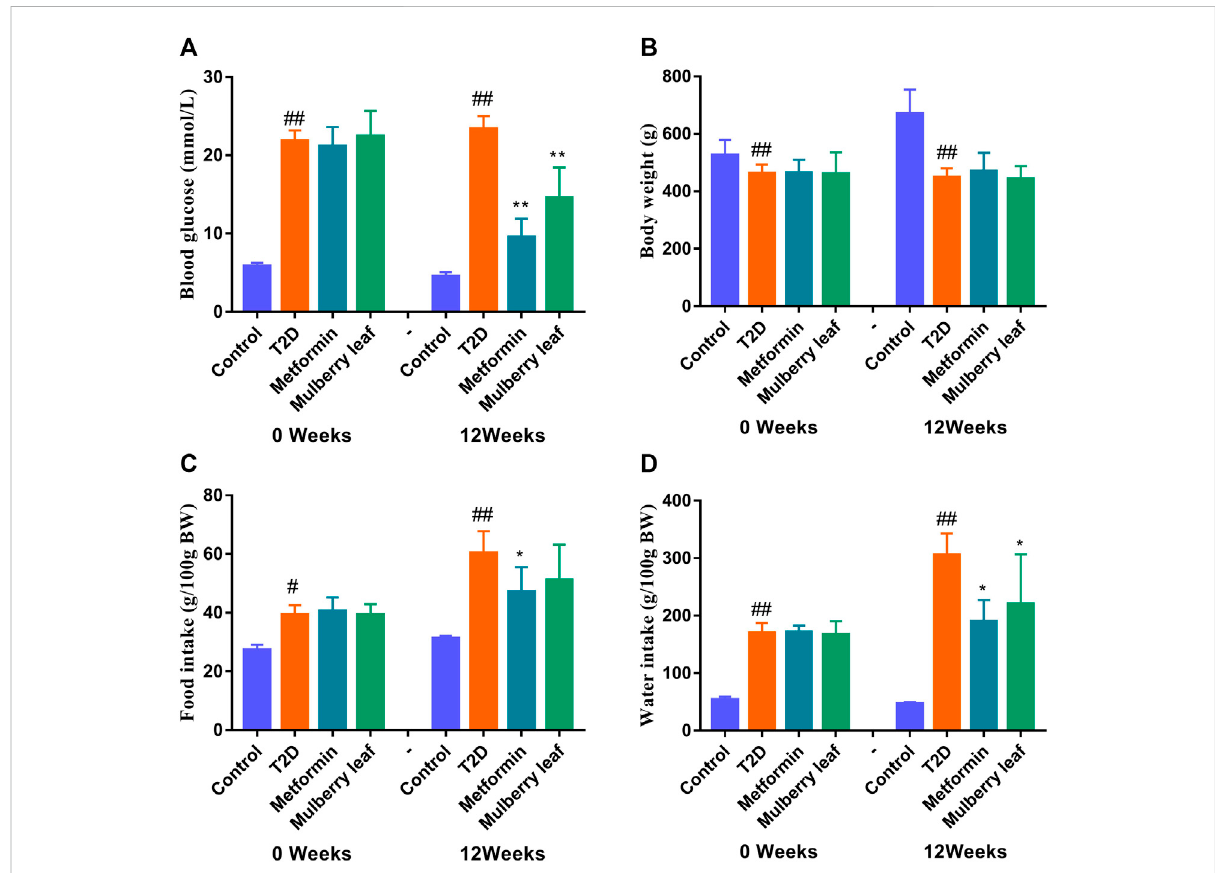
FIGURE 3 Fasting blood glucose, body weight, and food as well as water intake of rats before and after the ML treatment (A) Fasting blood glucose (B) fastingbodyweight (C) foodintake,and (D) waterintake.Datawerepresentedasthemean±SEM,n ≥ 7. # p < 0.05vs.thecontrolgroup, ## p < 0.01vs. the control group, * p < 0.05 vs. the T2D group, and ** p < 0.05 vs. the T2D